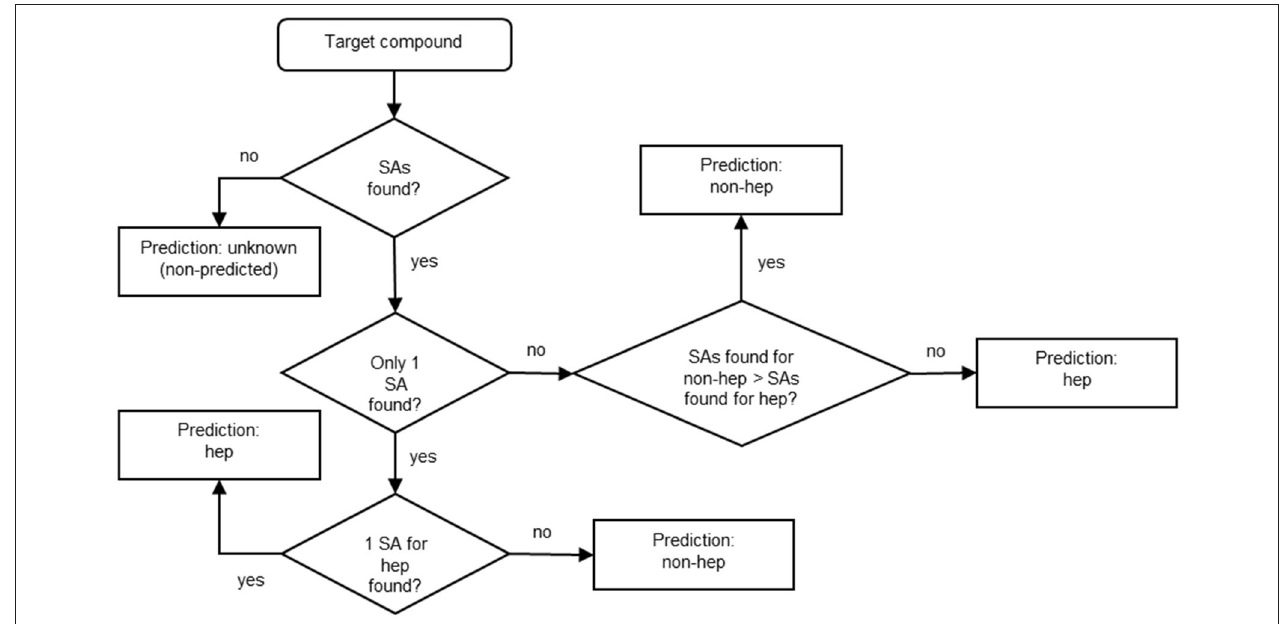
FIGURE 2 | Decision tree developed for the hepatotoxicity model. Hep stands for “hepatotoxic” and non-hep for “non-hepatotoxic.”